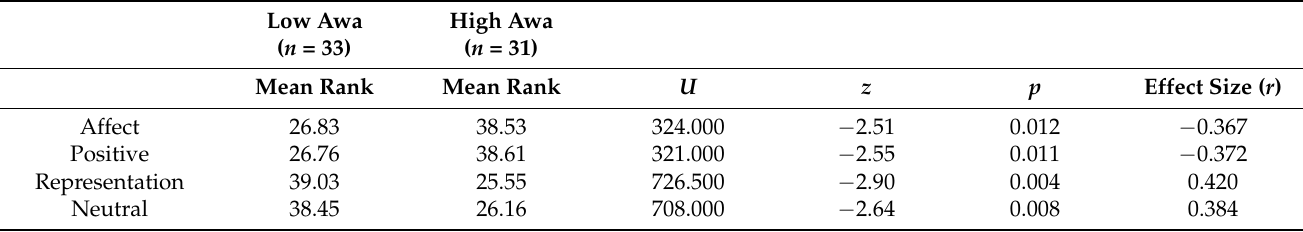
Table 4. Comparisons between awareness DSC subgroups for SSA